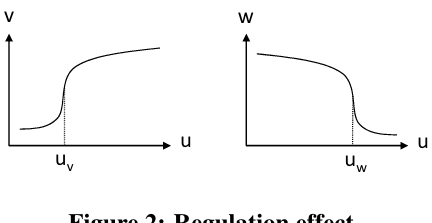
Figure 2: Regulation